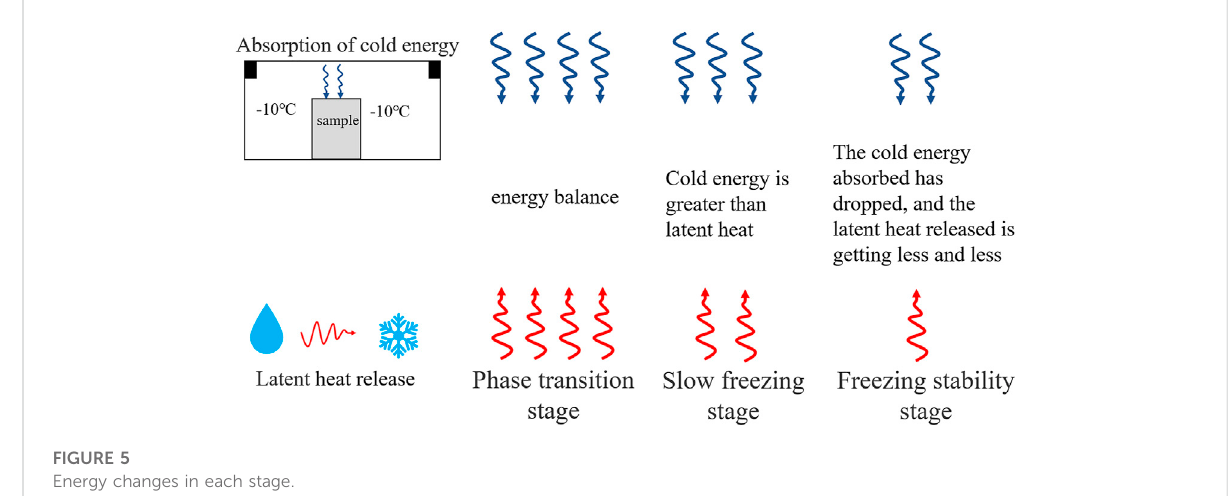
FIGURE 5 Energy changes in each